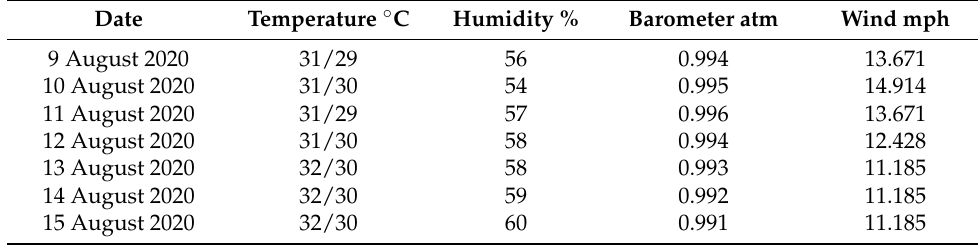
Table 1. Weather conditions during solar drying ([15], accessed on 15 September